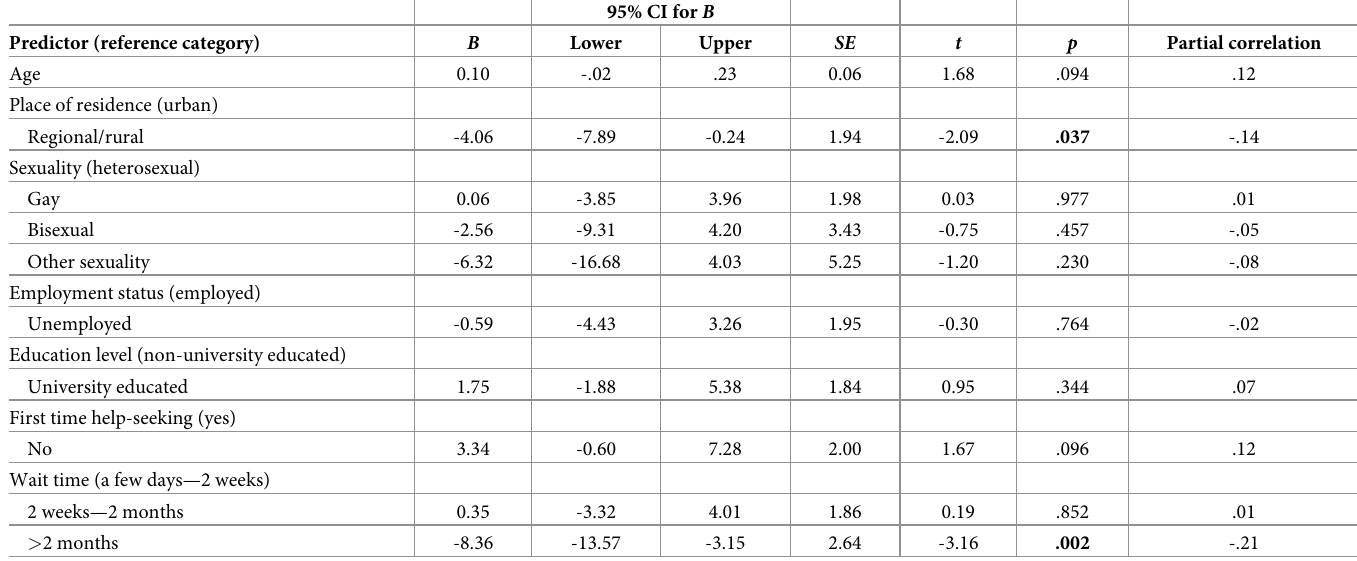
Table 2. Multiple linear regression of satisfaction with therapy according to demographic and help-seeking predictors, among those who had telemental healthcare.